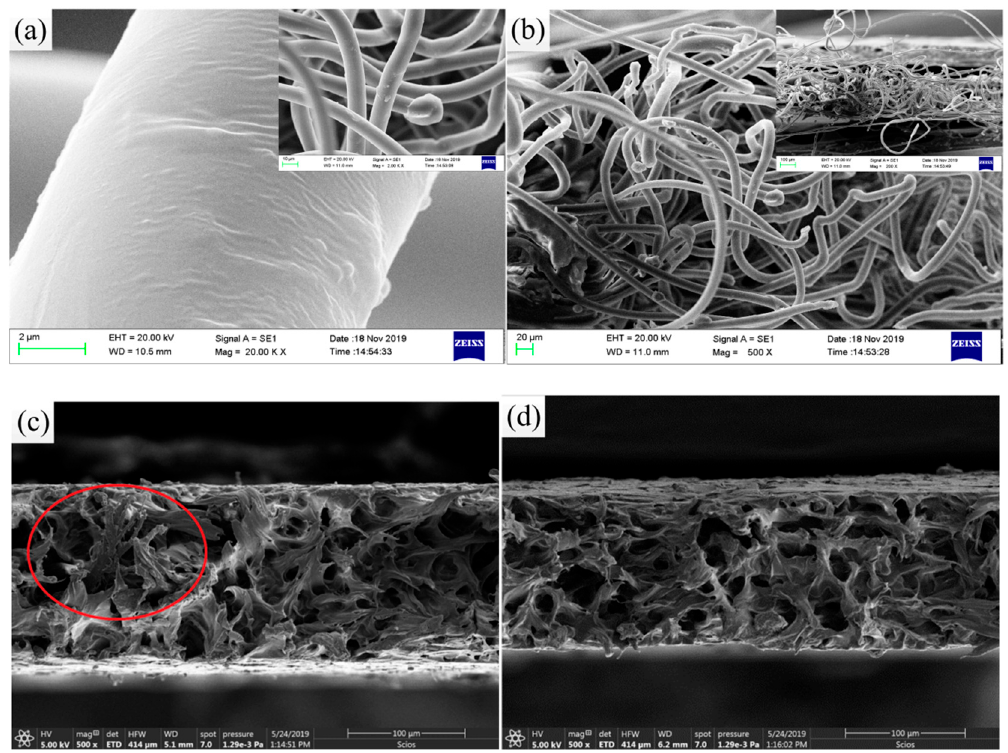
Figure 9. SEM of the cross section: ( a ) PP/SiO 2 /PVDF (4 wt %) magnified by 20,000×; ( b ) PP/SiO 2 /PVDF (4 wt %) magnified by 500×; ( c ) SiO 2 /PVDF (6 wt %) magnified by 500× and ( d ) SiO 2 /PVDF (4 wt %) magnified by 500×.